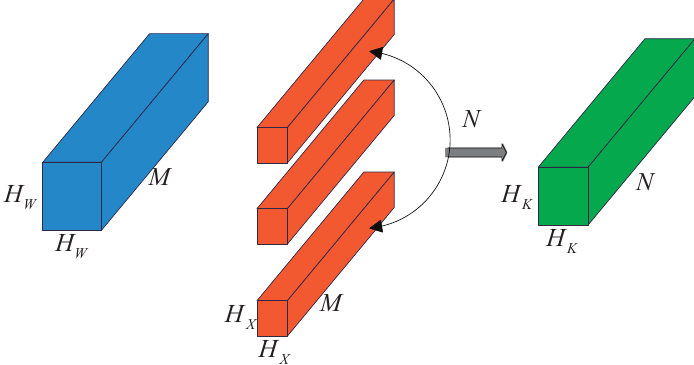
Figure 3. Conventional convolution calculation process. In-depth separable convolution is composed of depth convolution (Depthwise) and point convolution (Pointwise). Deep convolution works on each convolution channel, and point convolution integrates the convolution output of each channel. The calculation process is shown in Figure 4.